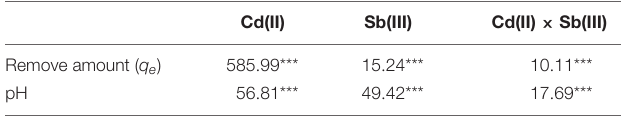
TABLE 1 | ANOVA results for effects of Cd(II), Sb(III), and their interactions on the biosorption characteristics of XK8. Cd(II)